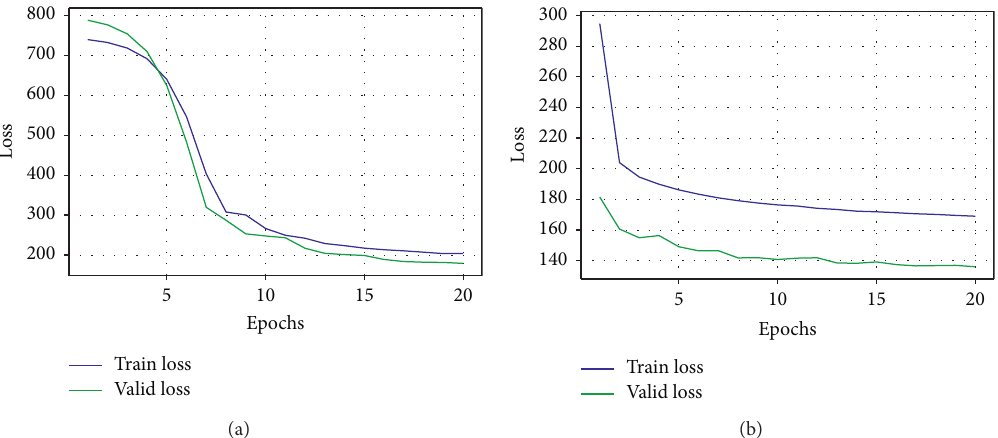
Figure 2: The behavior of the train and validation loss functions for the smallest and largest tested datasets. (a) Smallest dataset and (b) largest dataset.